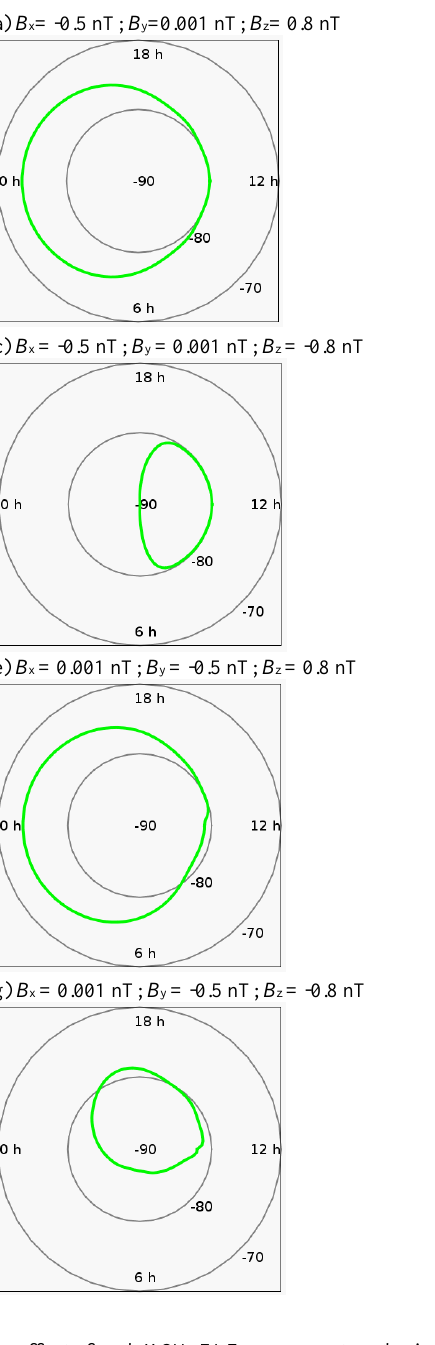
continues for case C due to a transition to relatively strong northward IMF conditions ( B z ≈ 0 . 3 nT), despite the smaller value of B y ≈ 0 . 3 nT. For image D the open flux is slightly